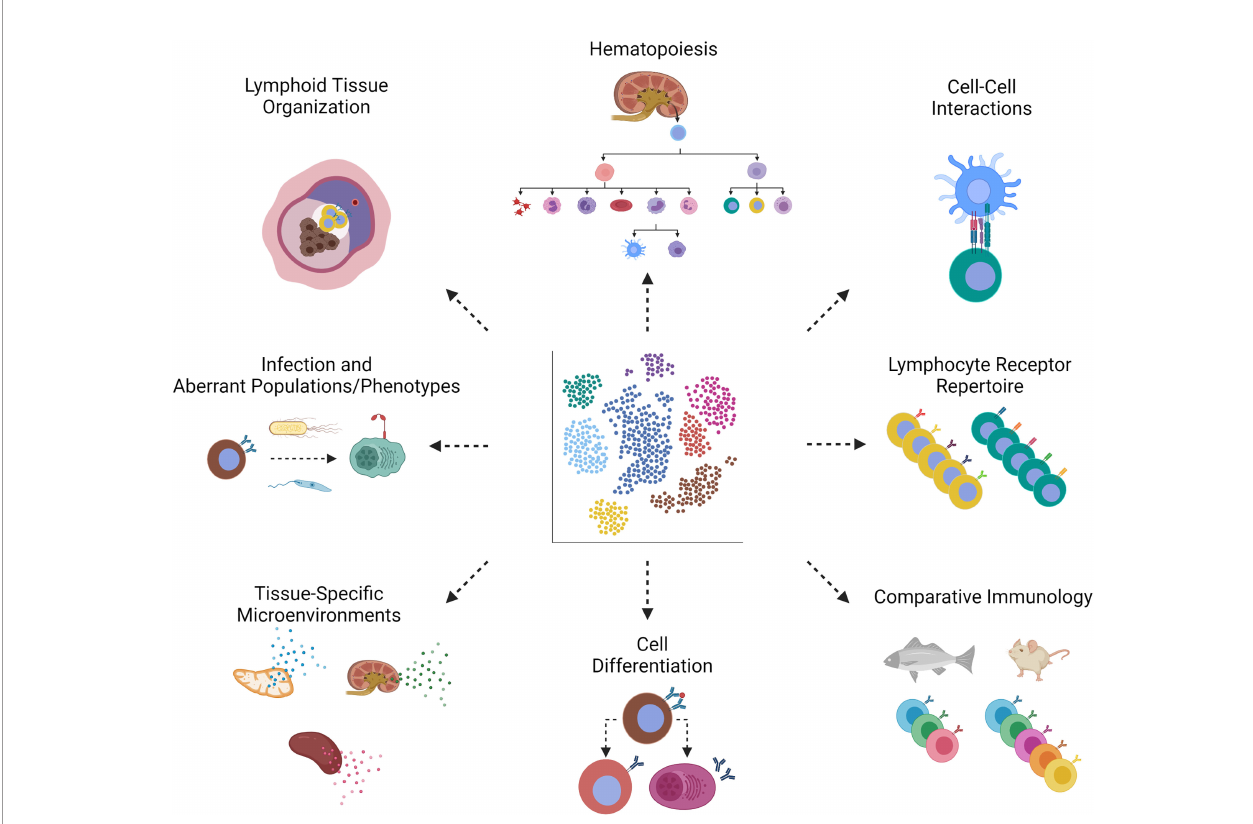
FIGURE 3 | scRNA-seq applications in teleost immunology. Through scRNA-seq of teleost fi shes, we can learn about the following aspects of bony fi sh immunology. (Clockwise, starting with the top left image, Lymphoid Tissue Organization) Depicted is splenic lymphoid tissue from fi sh, where we expect to discover markers of activation. The same markers can be used in techniques such as in situ hybridization to determine lymphoid tissue organization. Spatial transcriptomics provides both single-cell transcriptomic and spatial information in one method (108). (Hematopoiesis) The gain and loss of markers by hematopoietic stem cells throughout hematopoiesis help us piece together the developmental origins of fi sh leukocytes. (Cell-Cell Interactions) Complementary receptor-ligand pairs will reveal cells that interact during an immune response. (Lymphocyte Receptor Repertoire) Antigen (B or T cell) receptor repertoire sequencing bene fi ts from single-cell technologies in which sequences of heavy and light chains remain associated with a particular clone. (Comparative Immunology) Comparison of fi sh and mammals can, for example, identify gene orthologues or lack thereof. (Cell Differentiation) Depicted is the differentiation of an activated B cell into a memory B or antibody-secreting cell, each distinguishable by distinct markers. (Tissue-Speci fi c Microenvironments) The cytokine pro fi le, for example, can be distinguished between lymphoid tissues of thymus, kidney and spleen, in order to tell us about which cell types are resident to, homing to, or retained in these tissues. (Infection and Aberrant Populations/Phenotypes) Infection of fi sh hosts with bacteria or parasites may give rise to populations that are rare or non-existent in homeostasis, as identi fi ed by induced or loss of markers. Created with